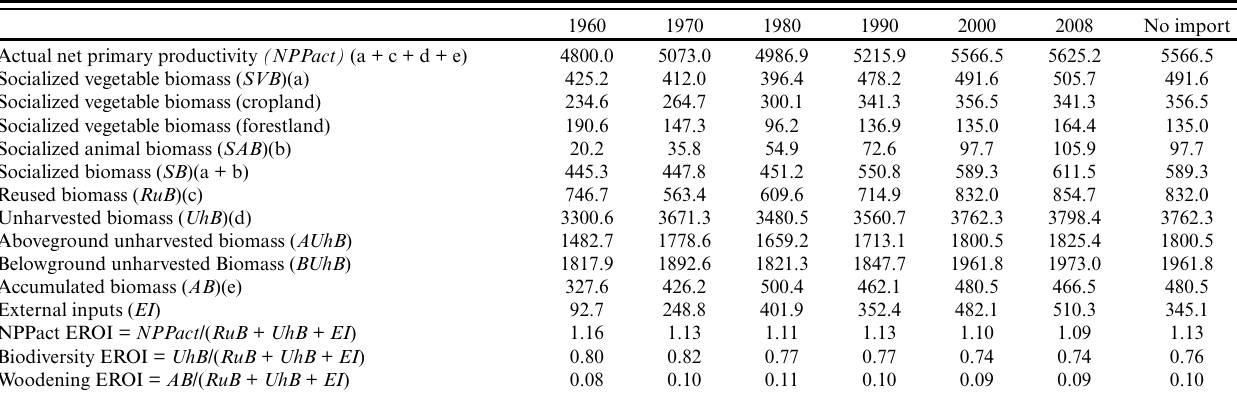
Table 1 . Actual net primary productivity, socialized animal biomass, external inputs, and agroecological energy return on investment (EROI) for the whole Spanish territory (in PJ).